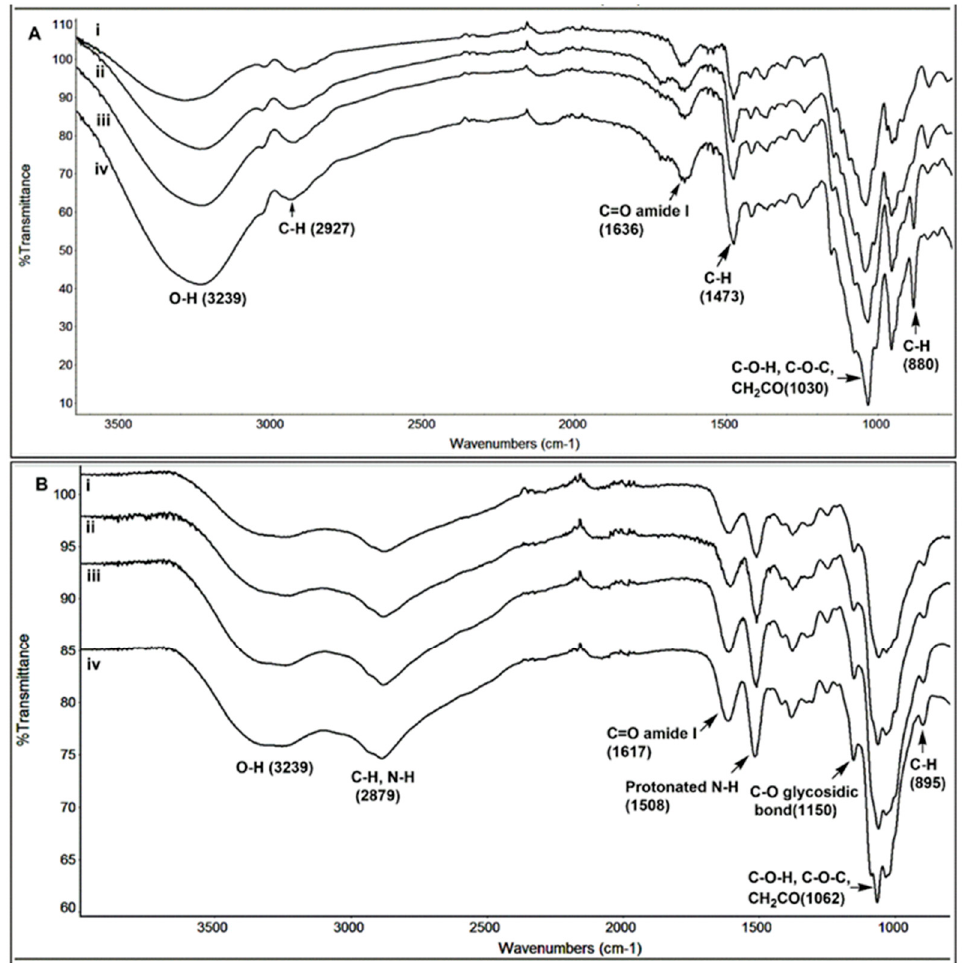
Figure 4. Figure showing the FTIR spectra of TMC ( A ) and chitosan ( B ) obtained after different stages of hydrolysis (1 h, 4 h, 48 h, and 528 h).